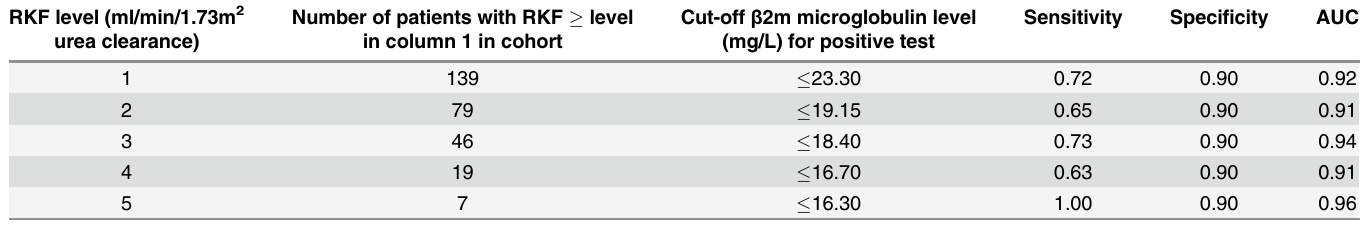
Table 5. Β 2-microglobulin level cut-off levels that may be used to identify patients with residual renal urea clearance. For various levels of residual urea clearance, the cut-off β 2-microglobulin level was determined that would yield a false positive rate (specificity) of 10%. For each level of urea clearance area under the curve (AUC) is shown for ROC analyses.